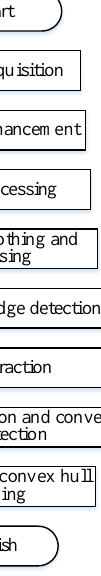
Figure 4. Rendering of the laser grid on the ground. As shown in Figure 4, the laser emitter is obliquely irradiated to the ground; the center line of the laser emitter is at α degrees to the horizontal plane; the laser emitter is at h 2 above the horizontal ground; and the distance between the laser emitter and the checkerboard laser grid is l . As shown in Figure 5, in an ideal case, the laser emitter is illuminated on the level ground, presenting a uniformly distributed laser grid with a single grid length of x 0 , and the width is y 0 . In reality, the laser grid is deformed by the laser emitter tilted on the ground. As shown in Figure 6, the laser network is an 8×8 grid; the laser line closest to the laser transmitter is the X-axis, and the central axis of the laser network is the Y-axis. The vertical distance between the flat laser line and the origin is 0 , y 1 , y 2 , …, y 8 , respectively. Due to the deformation of the vertical laser line, the endpoint is from − x 4 , − x 3 , …, 0 , …, x 3 , x 4 to − x 4 ’ , − x 3 ’ , …, 0 , …, x 3 ’ , x 4 ’ . Therefore, the X-direction of each grid is changed to: